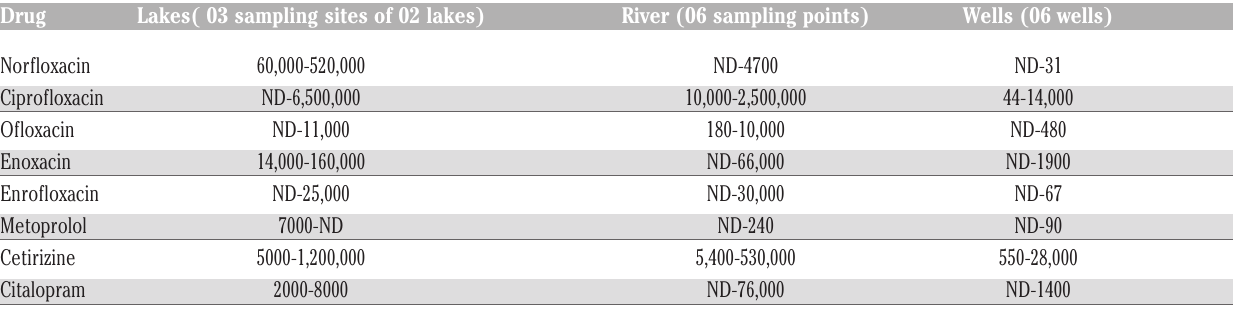
ND, not detected. Table 4. Physico-chemical characteristics in pharmaceutical industrial effluents. S. No.